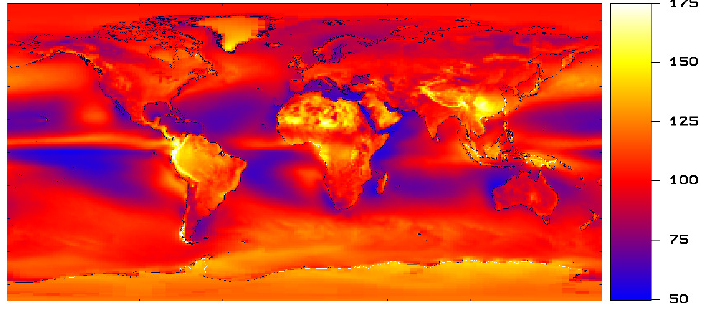
Figure 1. 2000–2018 mean all-sky CERES RSR. The scale is in W/m 2 .